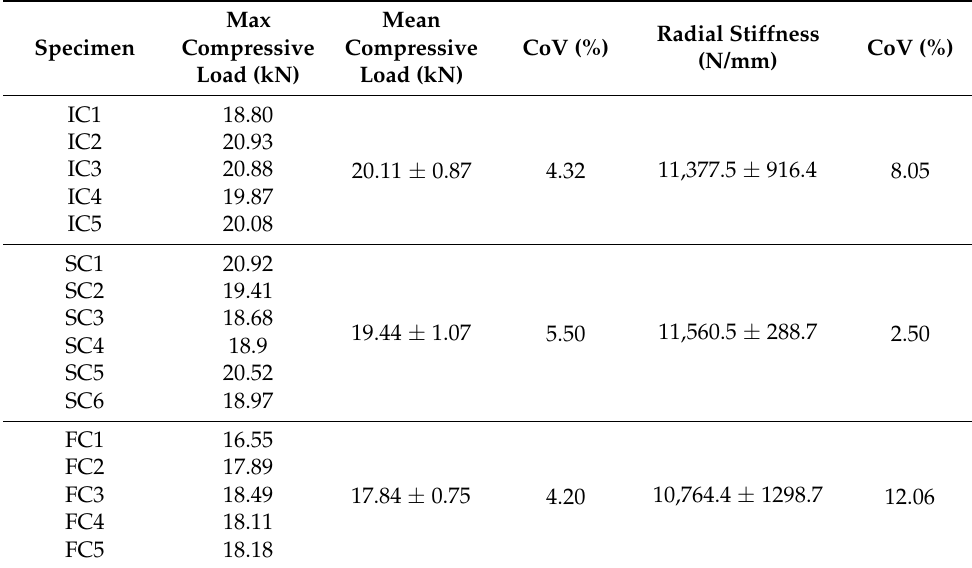
Table 3. Max loads for radial compression of